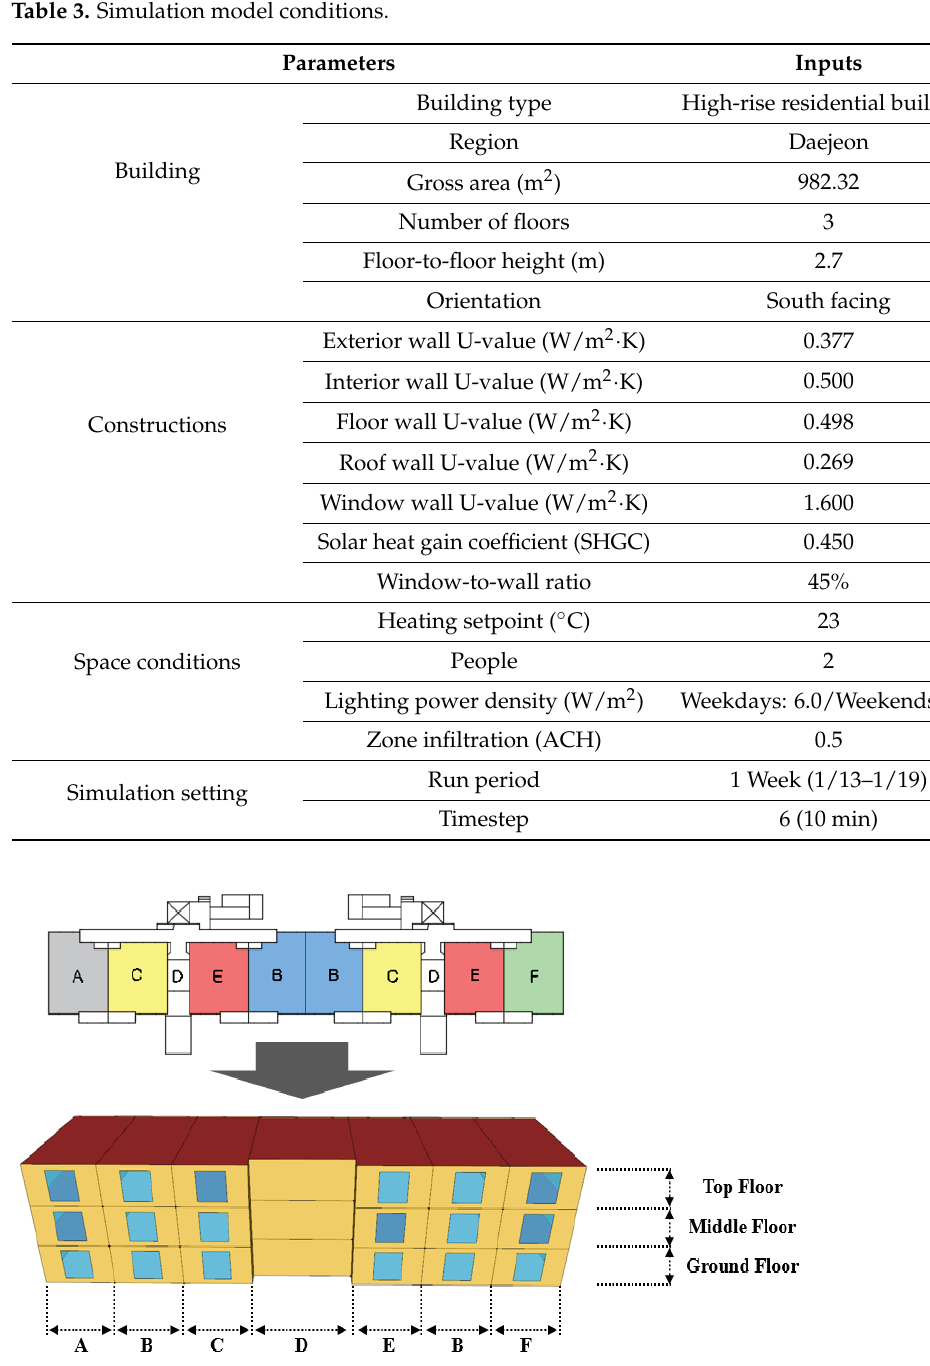
Figure 4. Schematic ANN model design. In this study, the ANN model was developed to determine input variables. Table 4 shows the information of the ANN model. The ANN model was developed using MATLAB’s Neural Network toolbox. The number of hidden layers (NHLs) was set to one layer. The number of hidden neurons (NHNs) value was calculated using Equation (1) [34], where N is the sum of the input and output variables. Therefore, in this study, NHN